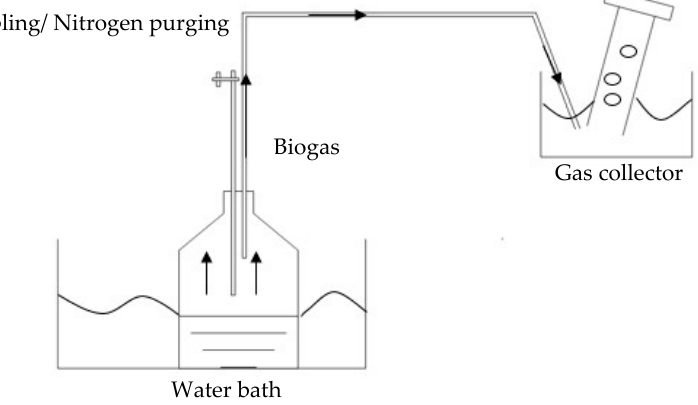
Figure 1. Schematic diagram of the anaerobic digestion process.